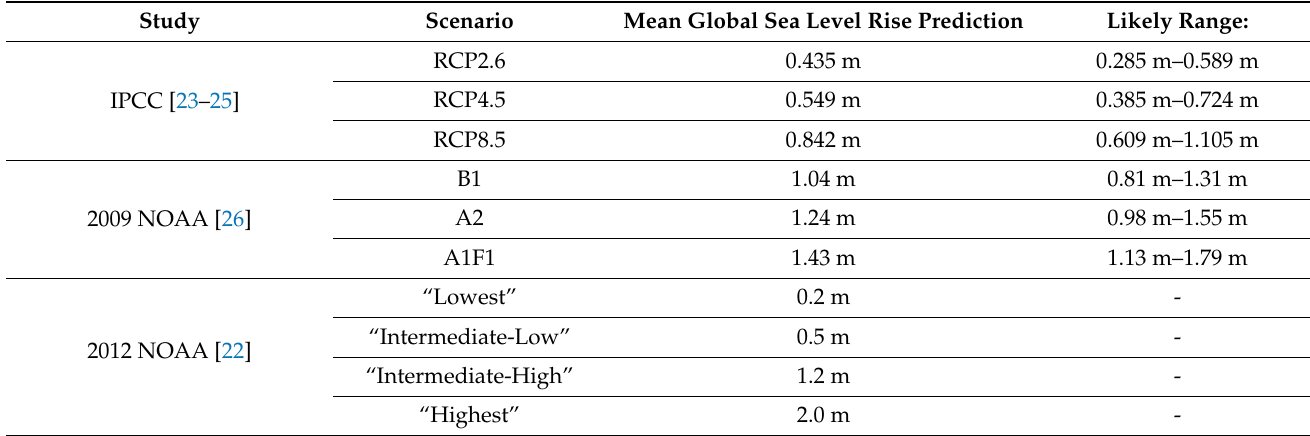
Table 1. Summary the results of the studies on global sea level rise. Source: own elaboration, on the basis of [22–26].